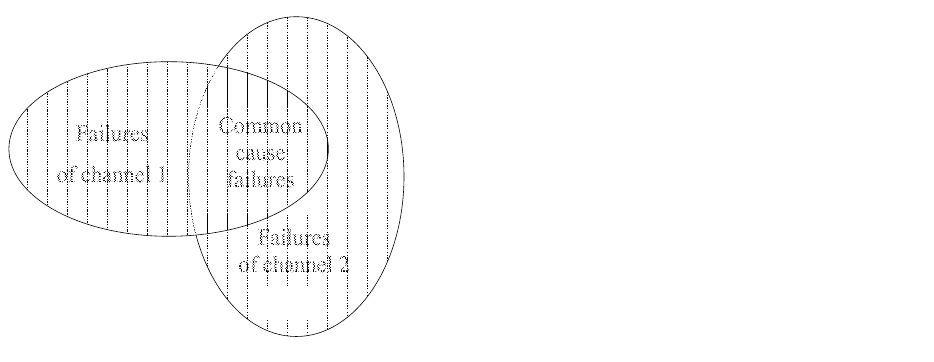
Figure 14. Contribution of common cause failures to the failures of individual channels and the